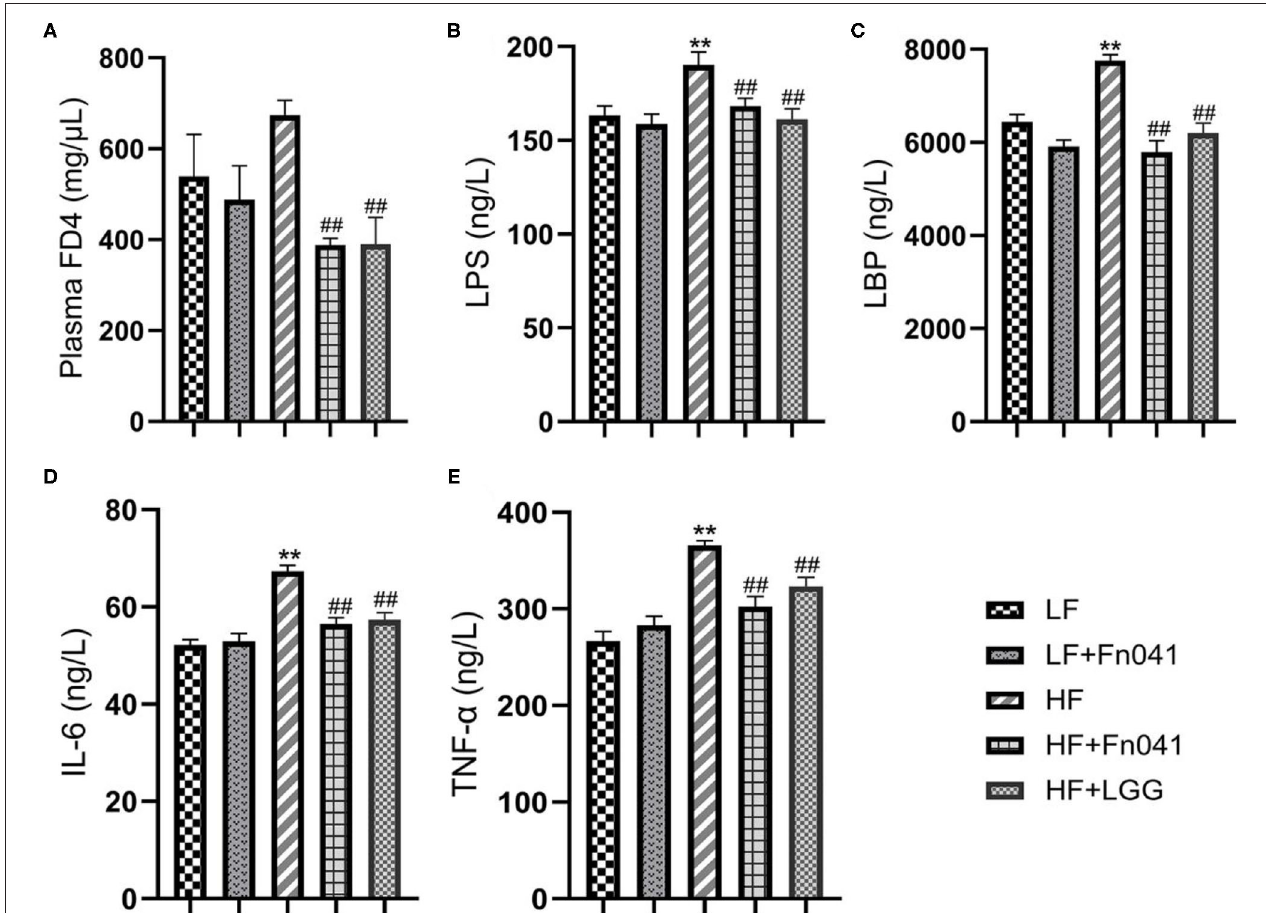
FIGURE 4 | Effects of Lactobacillus reuteri Fn041 on intestinal barrier dysfunction and chronic inflammation. (A) Plasma FITC-dextran 4000 (FD4) concentrations ( λ ex = 485; λ em = 530nm) measured 4h after gavage ( n = 5/group); (B) plasma lipopolysaccharide (LPS); (C) plasma lipopolysaccharide-binding protein (LBP); (D) plasma IL-6; (E) plasma TNF- α . Data are presented as mean ± SEM ( n = 12/group); **p < 0.01 as compared with the LF group; ## p < 0.01 as compared with the HF group. LF, low-fat diet group; LF + Fn041, low-fat diet group treated wit h L. reuteri Fn041; HF, high-fat diet group; HF + Fn041, high-fat diet group treated with L. reuteri Fn041; HF + LGG, high-fat diet group treated with Lactobacillus rhamnosus GG.